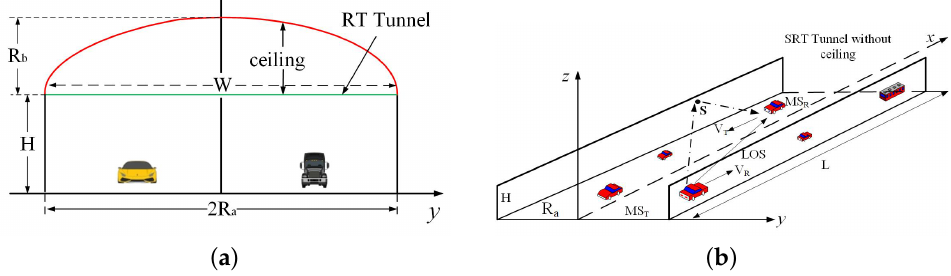
Figure 3. Propagation scenarios in RT and in SRT with an arch ceiling. ( a ) RT. ( b ) RT without